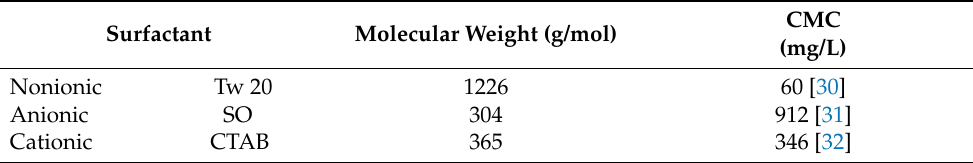
Table 2. Characteristics of surfactants used in this study.